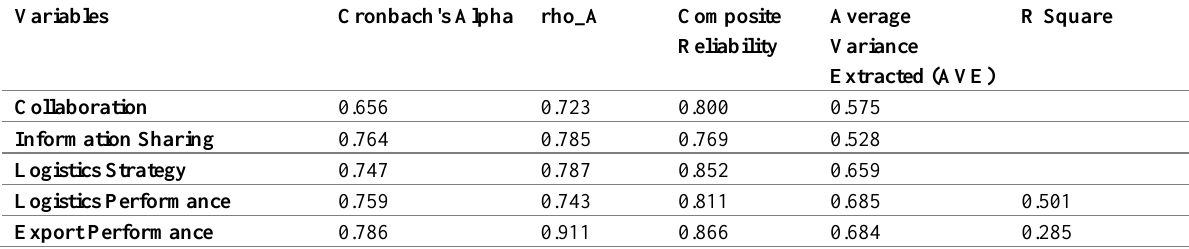
Table 4: Validity and Reliability